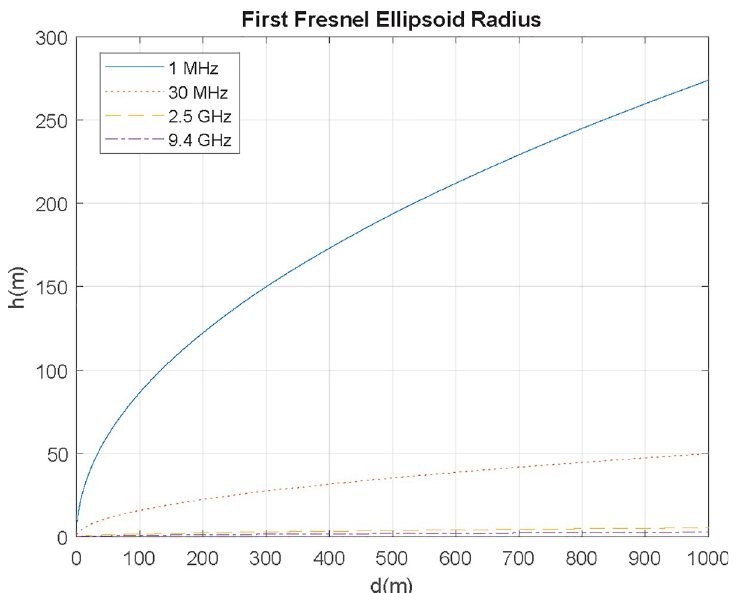
Fig 5. The first Fresnel’s ellipsoid radius (flight level) for different frequencies.